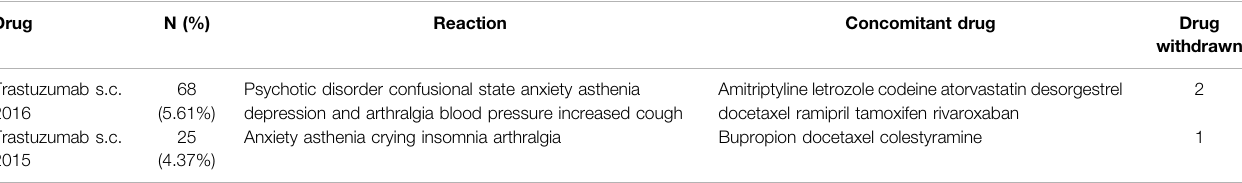
TABLE 6 | Cases of “ Psychiatric disorders ” of the intravenous and subcutaneous trastuzumab (2015 – 20). Drug N